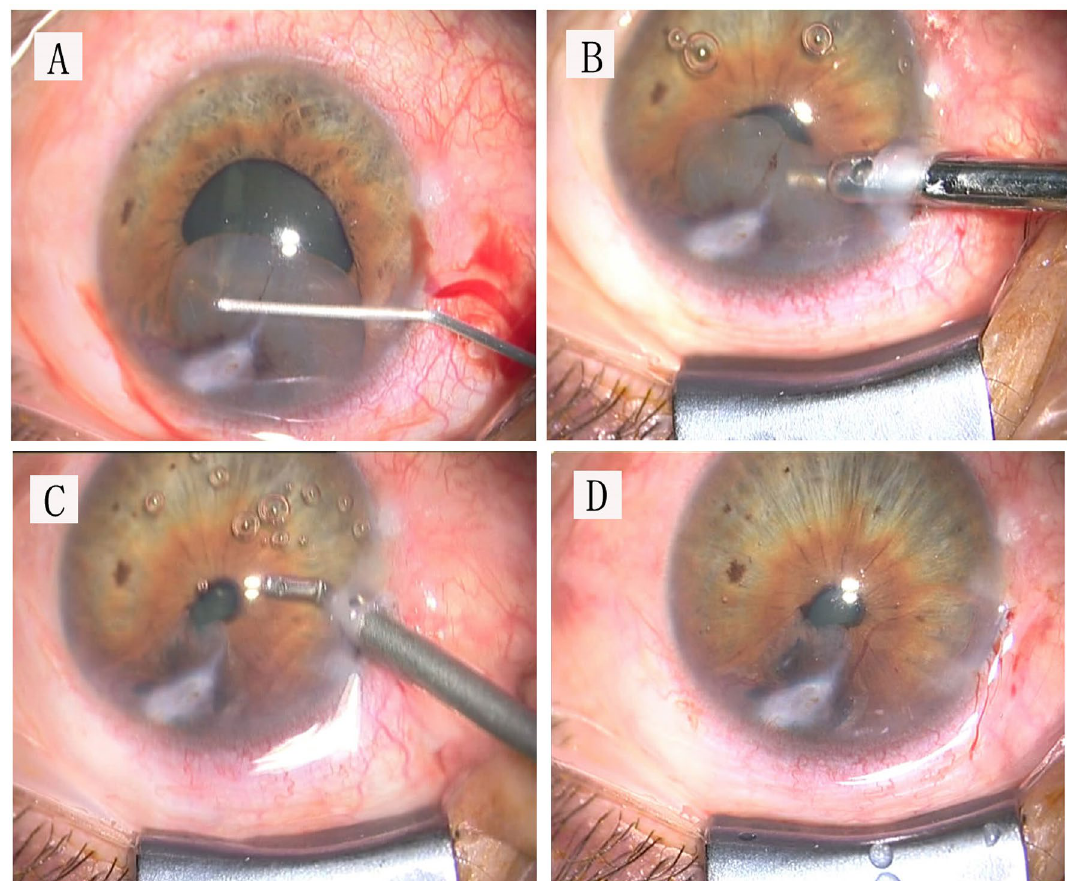
Figure 1. The main steps of “open iridectomy”. ( A ) The cyst wall was viscodissected from the corneal endothelium and anterior chamber angle till to the cyst base. ( B ) A 20-gauge vitrector was introduced to aspirate and resect the cyst wall till to the cyst wall/base which could preserve most iris stroma. ( C ) The cystic fluid and viscoelastic substance were removed by irrigation and aspiration. ( D ) The incision was